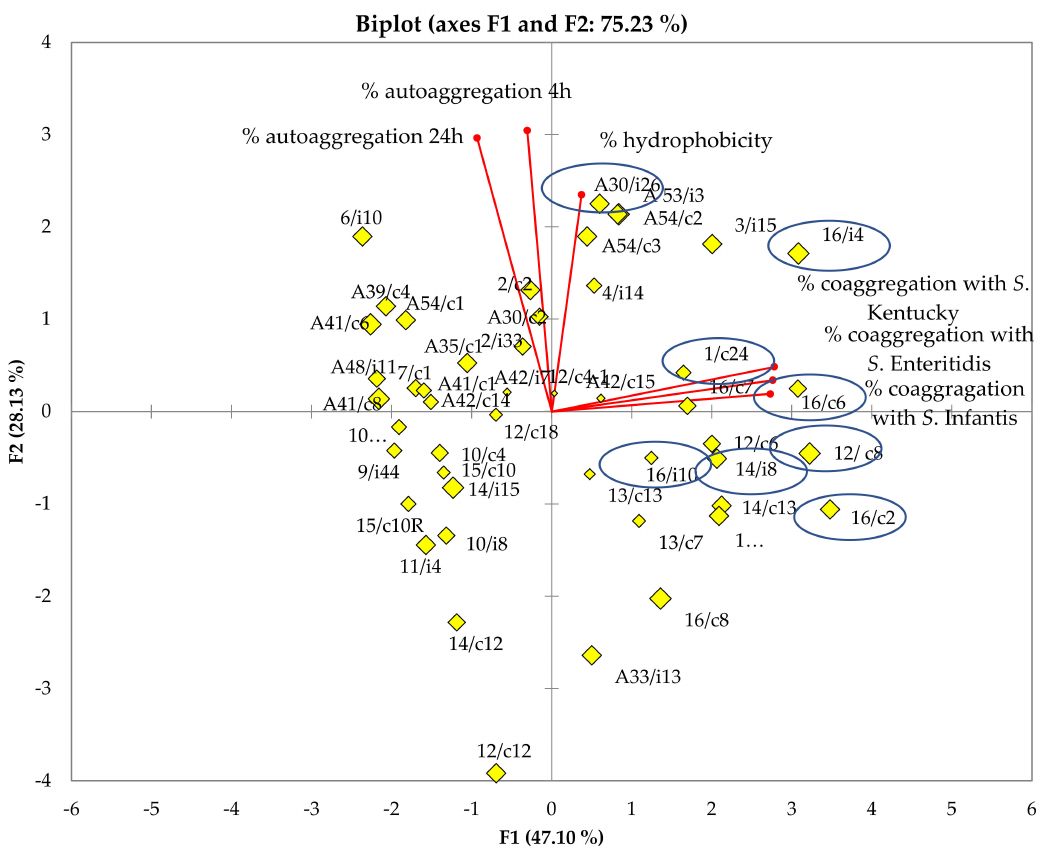
Figure 2. Isolate distribution in defined ranges of percentage of hydrophobicity, auto-aggregation and co-aggregation with the three Salmonella spp. ( S . Enteritidis (S.E.), S . Kentucky ST198 (S.K.) and S . Infantis (S.I.).